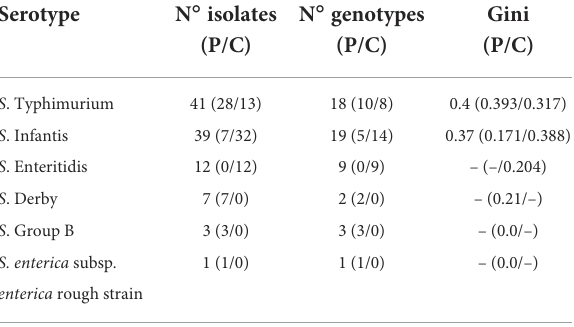
TABLE 1 Number of isolates, genotypes and Gini coefficients of serotypes detected in pigs (P) and chickens